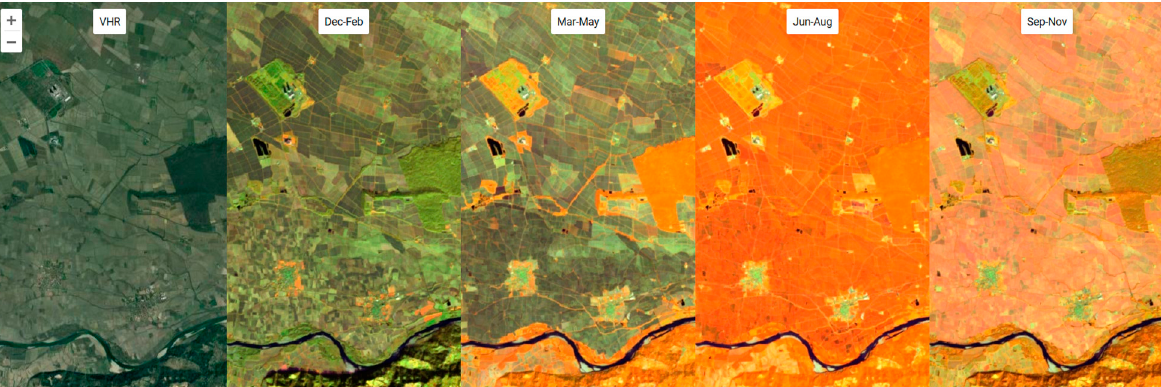
Figure 2. Inter-annual seasonal comparison of variation in colour and saturation for water, intensely irrigated crops, and hill shades, starting with a VHR (Very High Resolution) image, then showing seasonal variation with Landsat 8 imagery between 2013 and 2022 in R,G,B: NIR, SWIR1, Red. Location: Trino, north-western Italy, south-west of Vercelli, WGS84: 45°11 ′ 54.9 ″ N 8°15 ′ 49.3 ″ E.